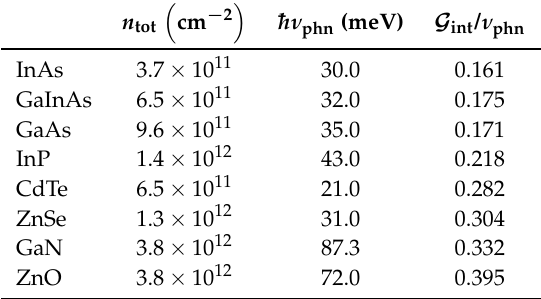
Table 1. Normalized coupling at resonance W MSB = ν phn as a function of the longitudinal optical (LO) phonon frequency for different materials [33]